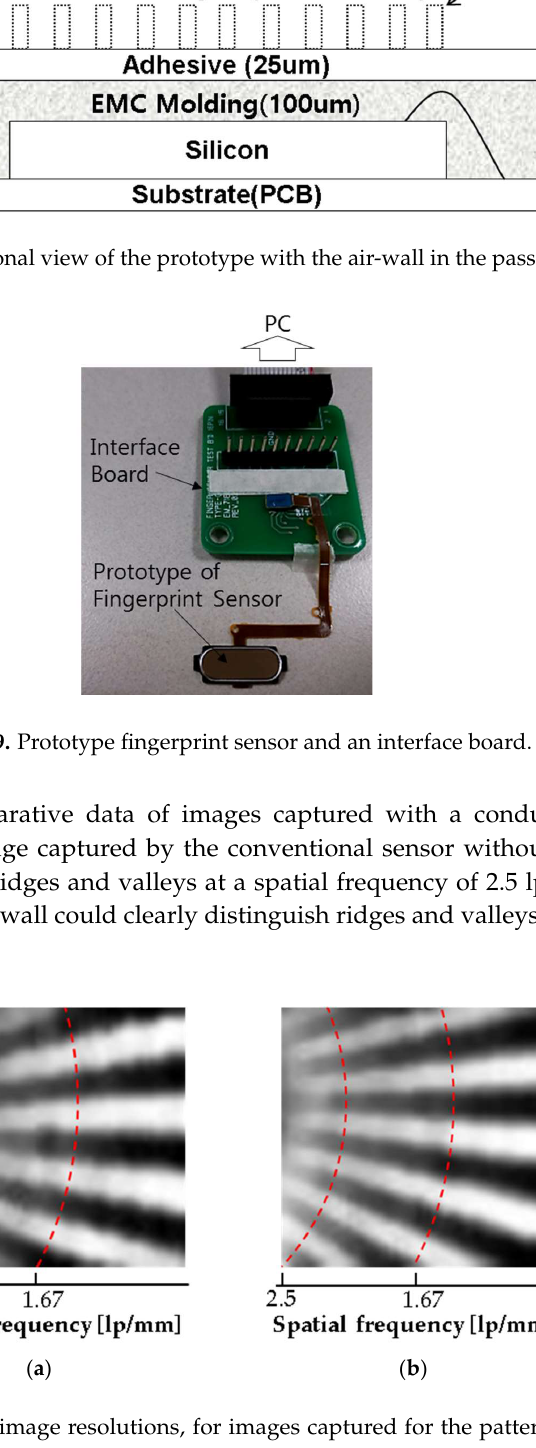
Figure 10. Comparison of image resolutions, for images captured for the pattern rubber with and without an air-wall: ( a ) without an air-wall in the passivation layer, ( b ) with an air-wall in the passivation layer.